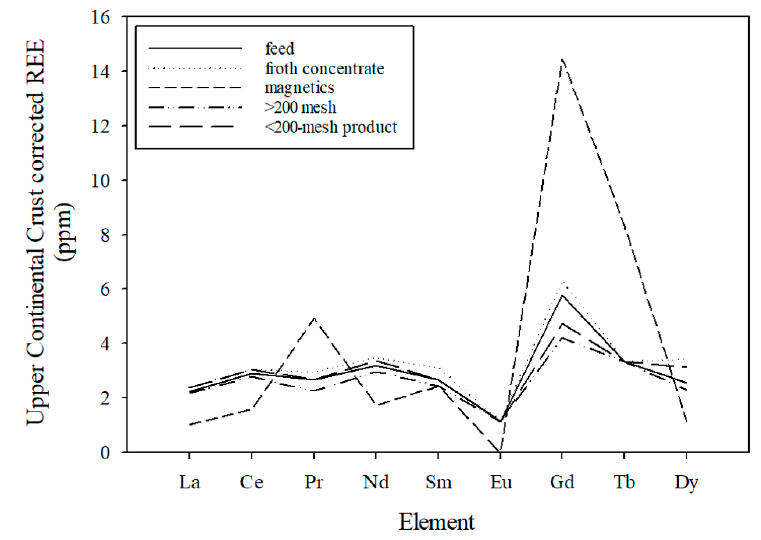
Figure 6. Spider plot of upper continental crust-corrected lanthanide distributions (correction factors after McLennan and Taylor [29]). Elements beyond Dy are not plotted due to the uncertainty in the odd-number elements.